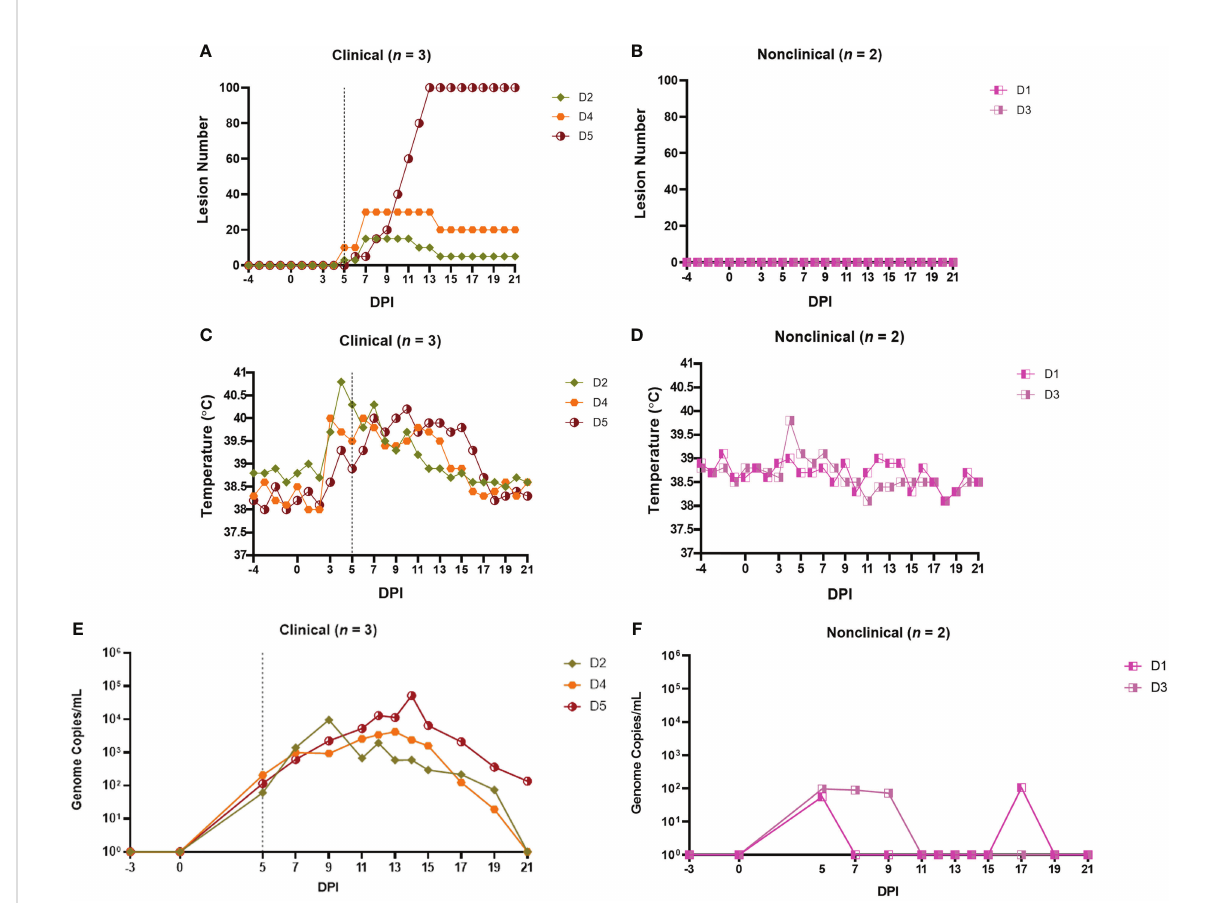
FIGURE 1 Clinical and virological outcomes of clinical and nonclinical calves after needle – inoculation with LSDV. The number of cutaneous lesions (A, B) were recorded each day, up to a maximum of 100 lesions. The rectal temperature of clinical and nonclinical calves (C, D) was recorded daily. The number of LSDV genome copies in the blood of each calf was quanti fi ed by qPCR (E, F) . A vertical dotted line represents the fi rst day cutaneous lesions were noted in the clinical